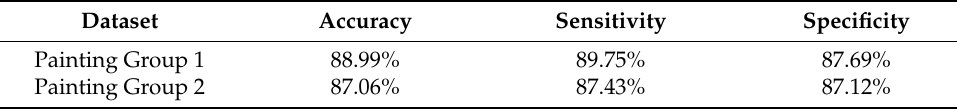
Table A8. Support vector machine scores for the 2 grouped painting datasets.